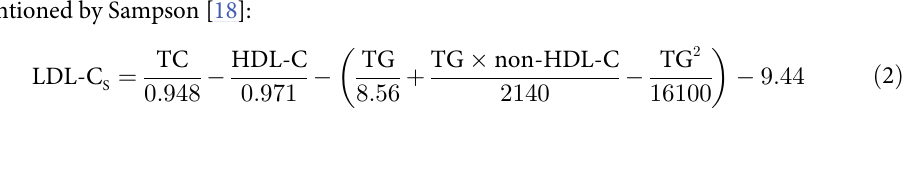
Different systems were used to directly measure HDL-C, LDL-C, triglycerides, and total cho- lesterol parameters. Detailed measurement procedures were given below according to used systems. Roche Cobas 8000, c-702 and c-501 : Total cholesterol, triglycerides and LDL-C, HDL-C measurements were performed using colorimetric enzymatic reaction. Siemens Advia 1800 : HDL-C levels were determined with Trinder reaction. Triglycerides and LDL-C, HDL-C measurements were performed using colorimetric enzymatic reaction. Beckman Coulter AU5800 : Total cholesterol, triglycerides and LDL-C, HDL-C measure- ments were performed using colorimetric enzymatic reaction.